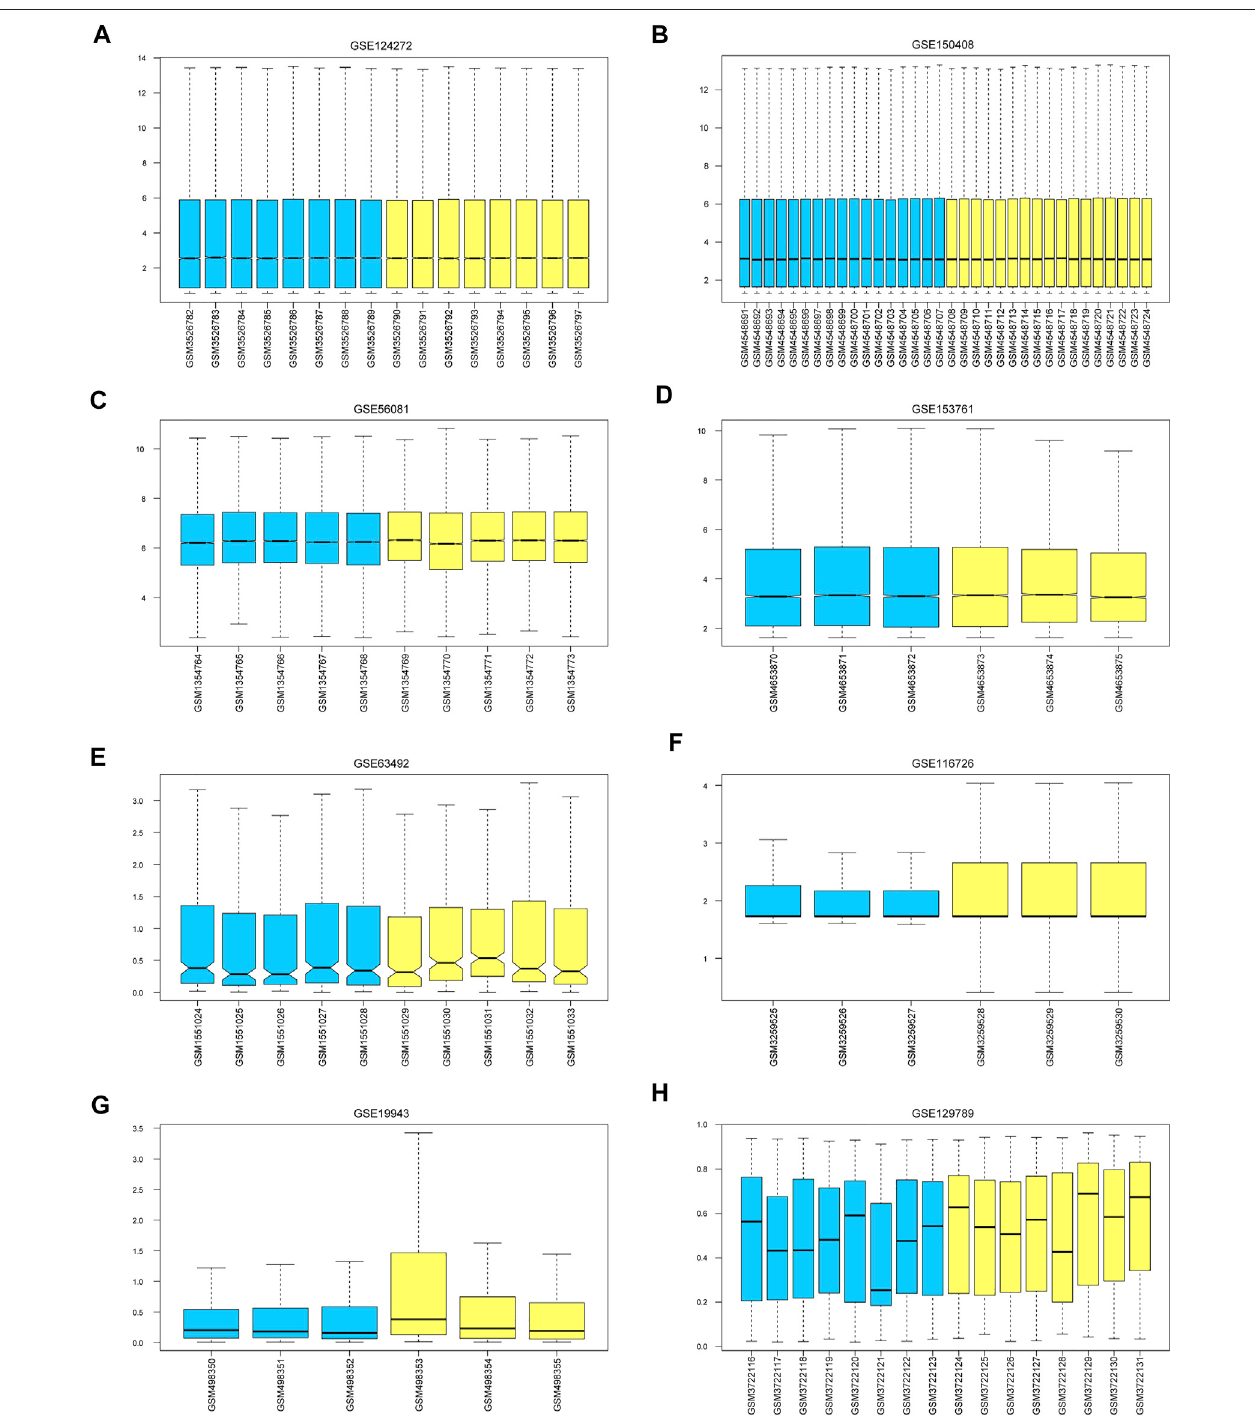
FIGURE 1 | Calibration of eight sets of data. The blue color represents the degenerative intervertebral disc tissue, and the yellow color represents the normal intervertebral disc tissue. We marked (A – H) represent the Calibration of eight sets of data.